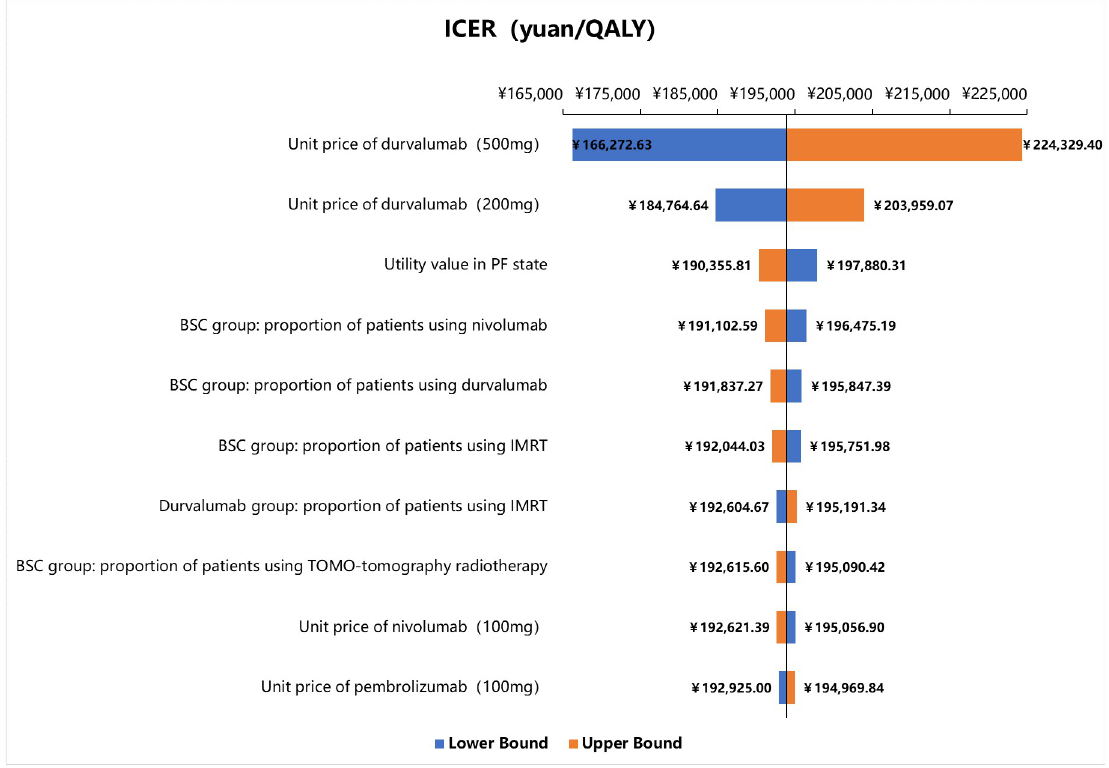
Fig 2. Tornado diagram of one-way sensitivity analysis. PF, progression free; IMRT, Intensity modulated radiotherapy; BSC, best supportive care.